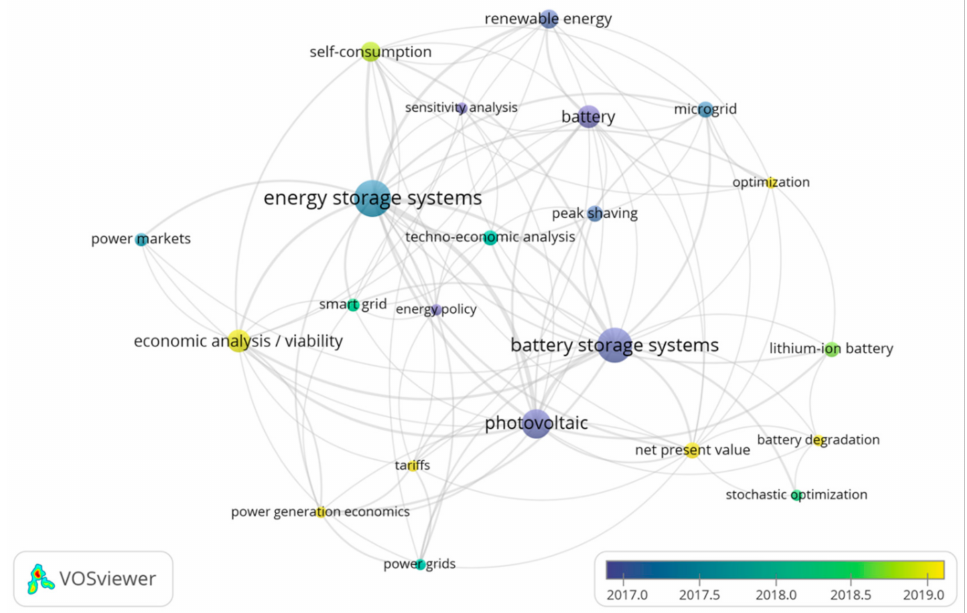
Figure 5. Keywords network. Source: